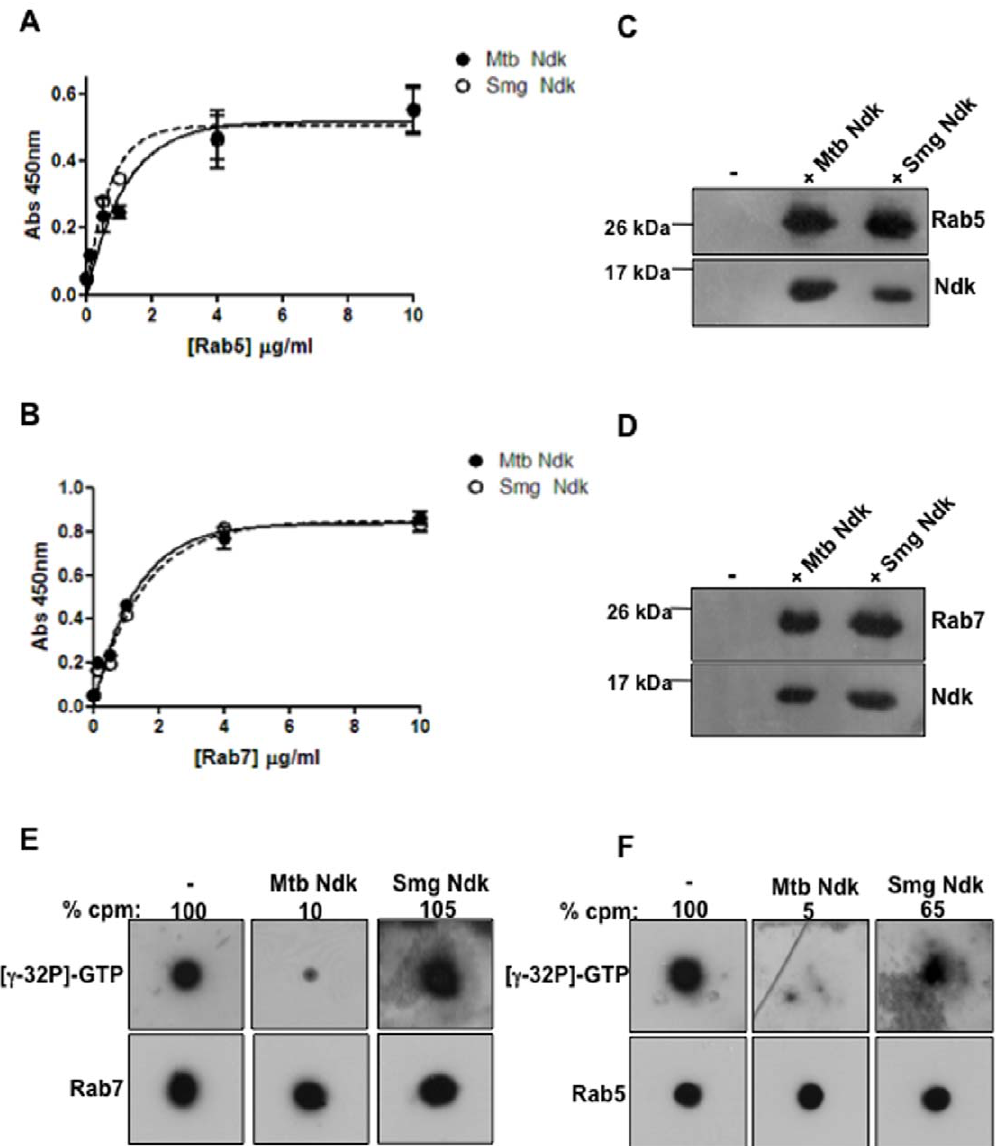
Figure 1. Ndk interacts with and deactivates Rab5 and Rab7 GTPases. A and B. ELISA microplates were coated with 10 m g/ml Mtb or M. smegmatis Ndk or control BSA, and incubated for 1 h with increasing concentrations of Rab5 or Rab7, previously loaded with 1 mM GTP in reaction buffer (50 mM HEPES pH 7.4, 50 mM NaCl, 0.1 mM DTT, 5 mM EDTA and 1 mg/ml BSA) for 10 min at 37 u C. Following 3 washes, attached Rab5 or Rab7 was probed with primary rabbit anti-Rab5 or Rab7, followed by secondary anti-rabbit-HRP conjugate. Thereafter, the interaction was visualized at absorbance 450 nm after addition of TMB substrate. Values from control BSA were subtracted. Results (mean 6 s.e.m) are from 3 independent experiments. C and D. Recombinant Ndk (3 m g) and GTP-loaded Rab5 or Rab7 (3 m g) were incubated in PBS buffer for 1 h at 4 u C. Thereafter, anti- Ndk antibodies (1:100) were added (1 h at 4 u C) and subjected to immunoprecipitation with protein A agarose beads for 30 min at room temperature. Samples were washed three times then analyzed by SDS-PAGE and western blot with anti-Ndk and anti-Rab5 or anti-Rab7 followed subsequently by monoclonal anti-rabbit IgG, native-peroxidase. Pulled down Rab7 and Rab5 are shown as the 25 kDa and 27 kDa protein bands respectively, while the 15 kDa protein band correspond to Ndk. E and F. Recombinant Rab5 and Rab7 were loaded with [ c - 32 P]-GTP and spotted onto nitrocellulose membranes. After extensive washes, membranes were either left untreated or incubated with recombinant Mtb or M. smegmatis Ndk at room temperature for 2 h. Membranes were washed, dried and exposed to X-ray film (upper panel). The radioactive signal observed depicts remaining active GTP-Rab7 or -Rab5 on membranes and values are quantification of bound [ c - 32 P]-GTP relative to control untreated samples as determined by radioactive count in a liquid scintillation counter. After film development, membranes were probed with anti-Rab7 to ensure equal spotting of Rab7 protein (lower panel). doi:10.1371/journal.pone.0008769.g001 findings, M. smegmatis Ndk, which has only minor effect on Rab GTPases, did not oppose bead phagosome fusion with lysosomes. infected with red fluorescent (PKH-labelled) BSA-beads and unlabelled Ndk-beads (or BSA beads, control). The expectation was that protein released from Ndk-bead phagosomes would act